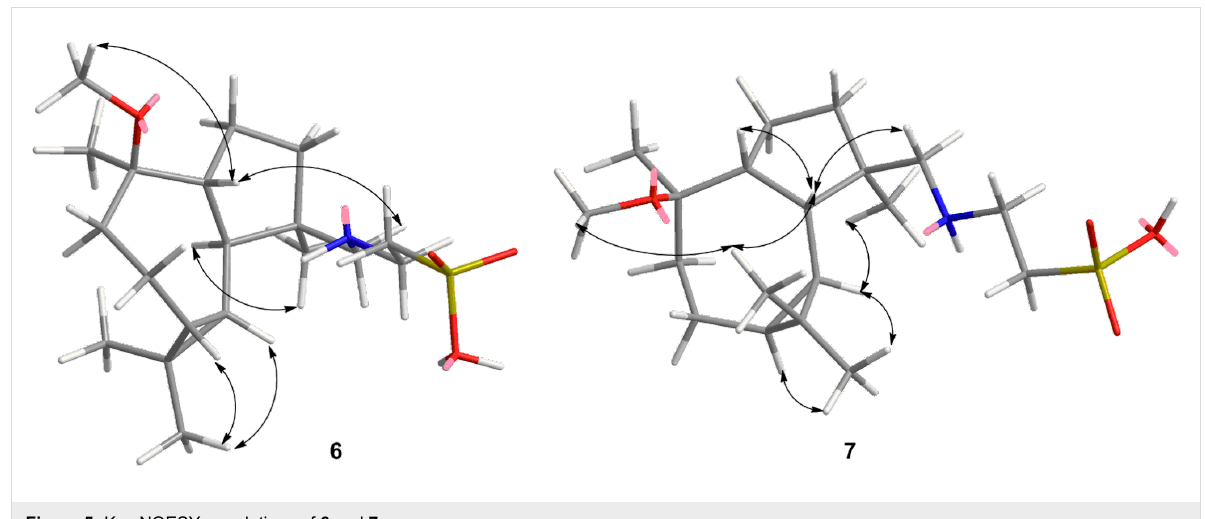
Figure 5: Key NOESY correlations of 6 and 7 .